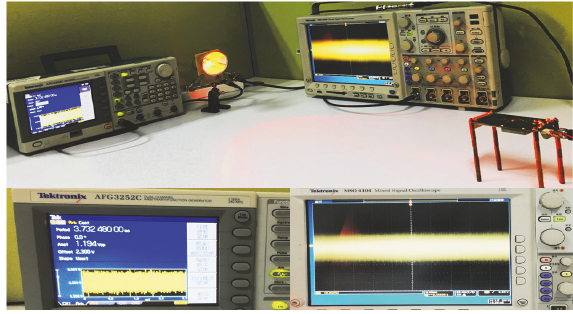
Figure 5: Experimental setup of the VLC